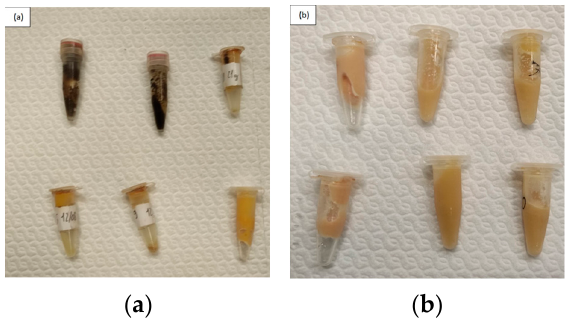
Figure 2. ( a ) Samples collected 20 days after the hatching; ( b ) Samples collected 70 days after the hatching.